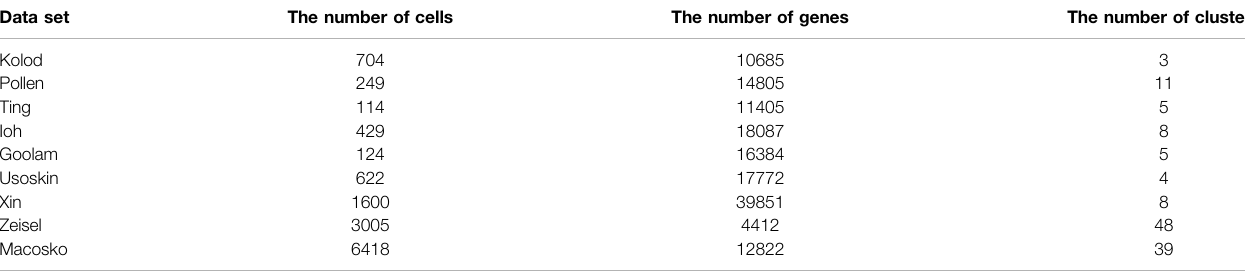
TABLE 1 | Summary of six scRNA-seq data sets used in this study. Data set The number of cells The number of genes The number of clusters Kolod